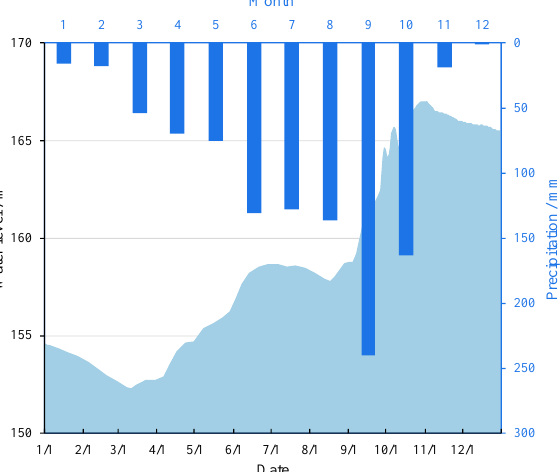
Figure 2. Temporal variation of water levels and precipitation in DJKR during the sampling periods in 2017. The area plot with the bottom x -axis and left y -axis represents the changes in water level. The histogram with the top x -axis and right y -axis represents the accumulated precipitation in each month. The sampling months of this study are indicated with grey bars.